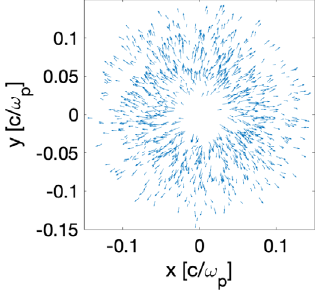
FIG. 7. The direction of the transverse momentum of 1000 sampled